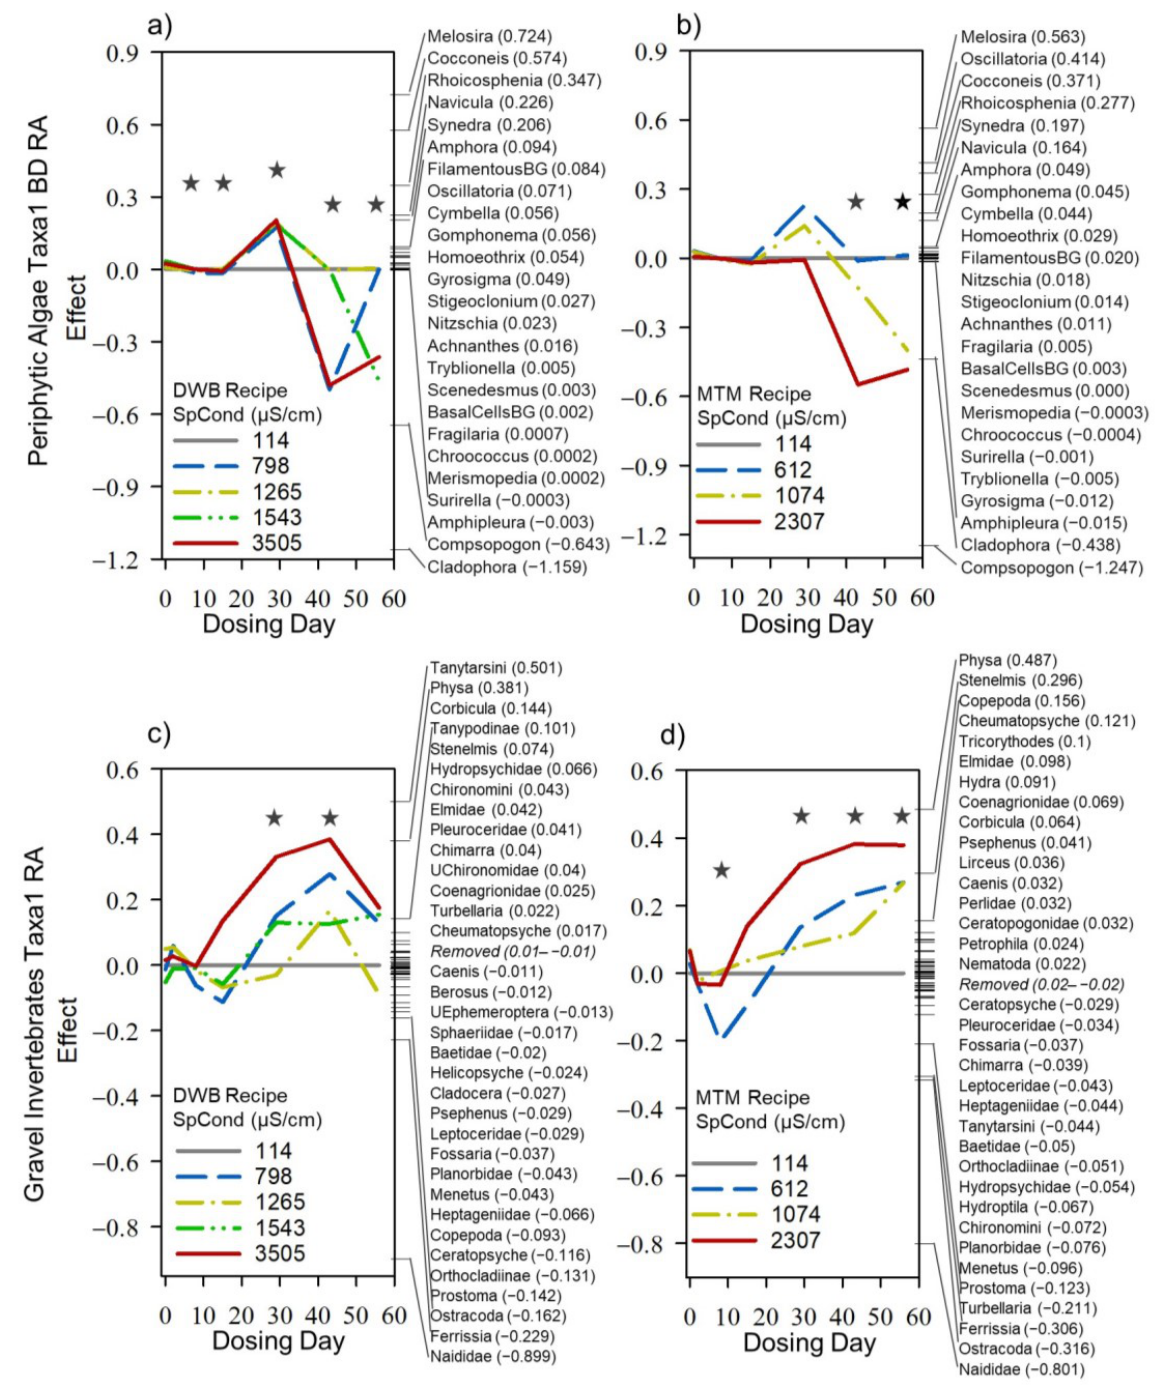
Figure 7. PRCs for community-level measures: periphyton biovolume densities and gravel inverte- brate counts relative abundances for DWB ( a , c ) and MTM ( b , d ) recipes, respectively. PRCs are based on Euclidean distance. Stars designate that the results of the permutation test indicated at least one significant difference in community assemblage across doses for the corresponding dosing day. Taxa and their relative loadings (in parentheses) on secondary y-axis (see Supplementary Materials for interpretation). Inconsequential taxa removed from listing for ( c , d ) for legibility. Table S12 includes complete PRC taxa loading lists. PRC results for each dose are normalized to the control, horizontal line at zero.